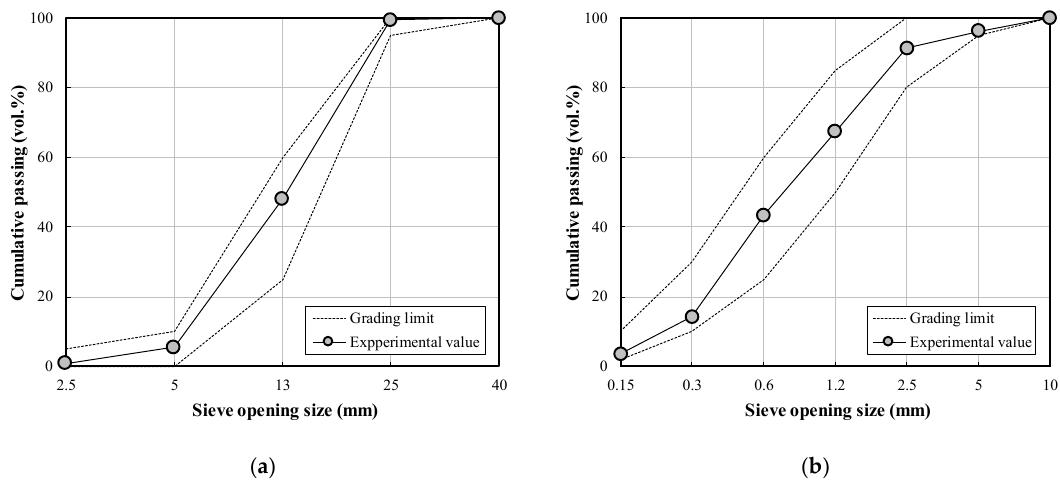
Figure 1. Gradation sieve analysis curves of aggregates used: ( a ) coarse aggregates; ( b ) fine aggregates. As for chemical admixtures, a PC-based admixture (polycarboxylic acid group) and a